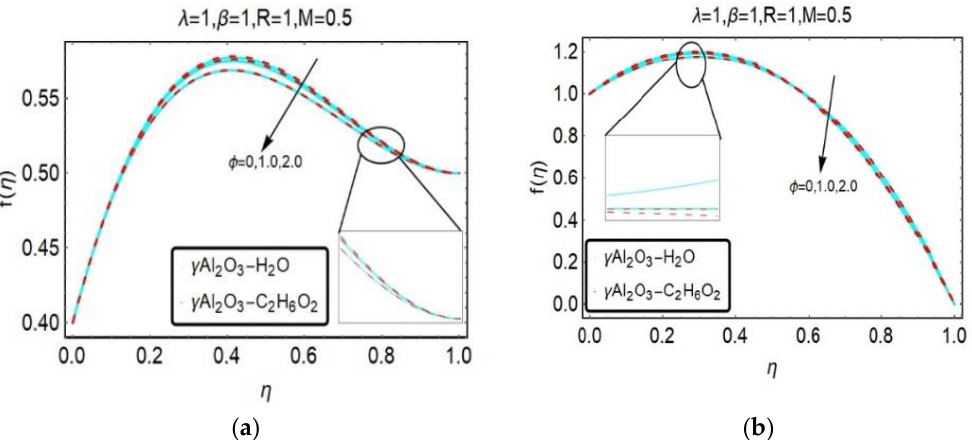
Figure 5. Influence of 𝜆 on 𝑓(𝜂) for ( a ) 𝑆 > 0 and ( b ) 𝑆 < 0 .